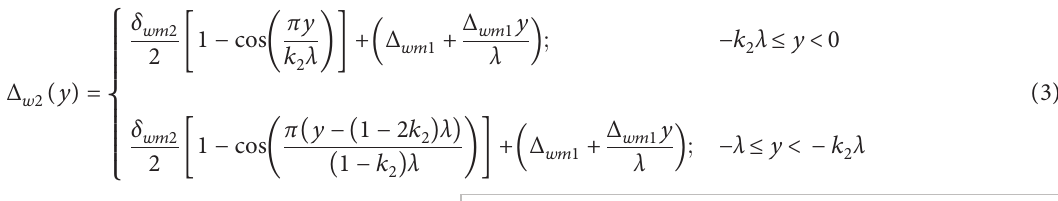
Figure 10: Relationship between the maximum lateral movement and the excavation depth.